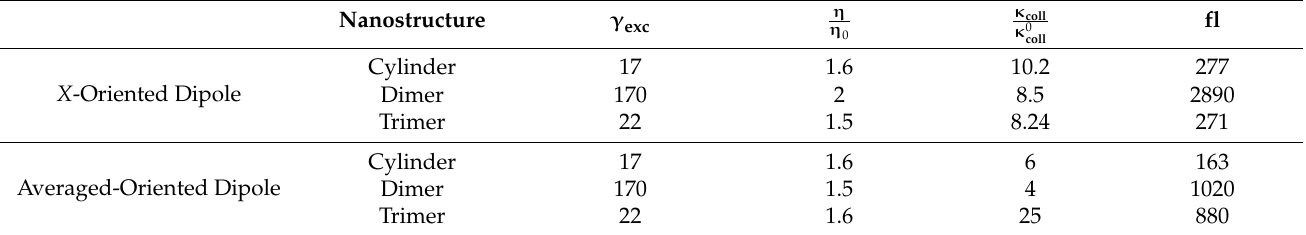
Table 3. Comparison of the fluorescence enhancements of an emitter coupled with arrays of differ- ent geometries at λ = 650 nm. The dipole is in the gap of the dimer and trimer and on the side of the cylinder.